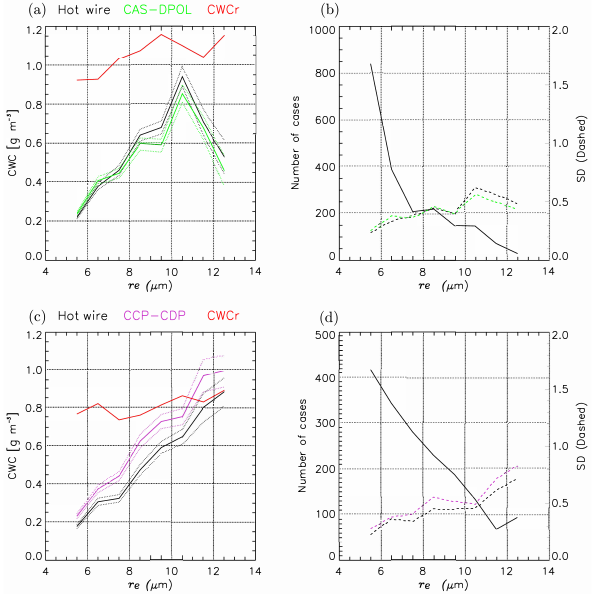
Figure 4. Mean cloud water content from the hot-wire measure- ments and estimated from the cloud probes (CCP-CDP and CAS- DPOL) as a function of effective radius ( r e ) size (a, c) . The ratios between the hot-wire liquid water content and the cloud water con- tent derived from each probe are shown in red (CWCr). The total un- certainties for each probe and the hot-wire measurements are shown by the dotted lines. The number of cases (black continuous line), hot-wire measurement standard deviations (dashed black line), and probe CWC standard deviations (dashed colored line) for each r e size are also shown (b, d)